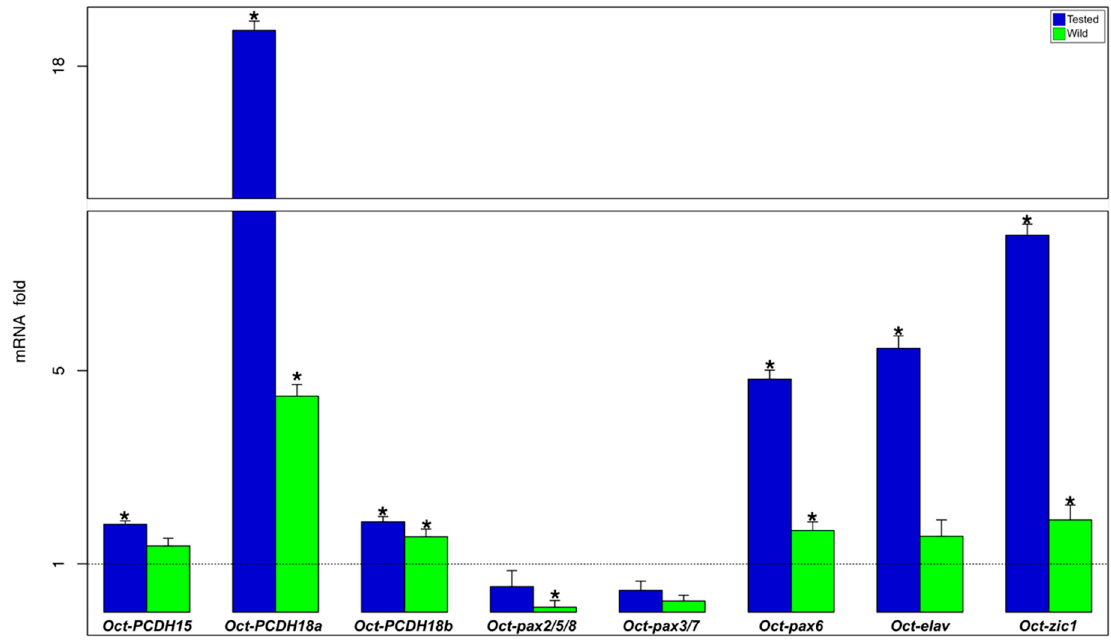
Figure 4. Gene expression analysis in OOP. Relative mRNA fold change in gene expression in tested (blue) and wild (green) octopus are compared to the control (N = 6/group; dot line set y = 1). * asterisk indicates that the difference vs. control group is statistically significant (Wilcoxon-test, p < 0.05). Error bars represent the SEM.